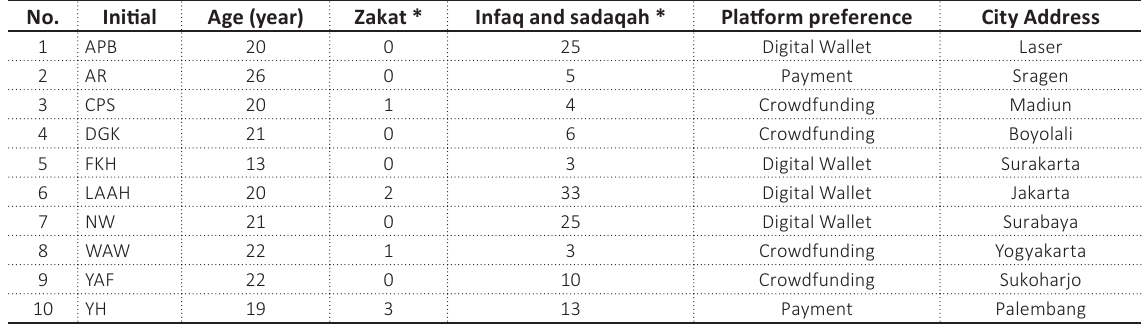
Source: Data owned and processed by the authors.